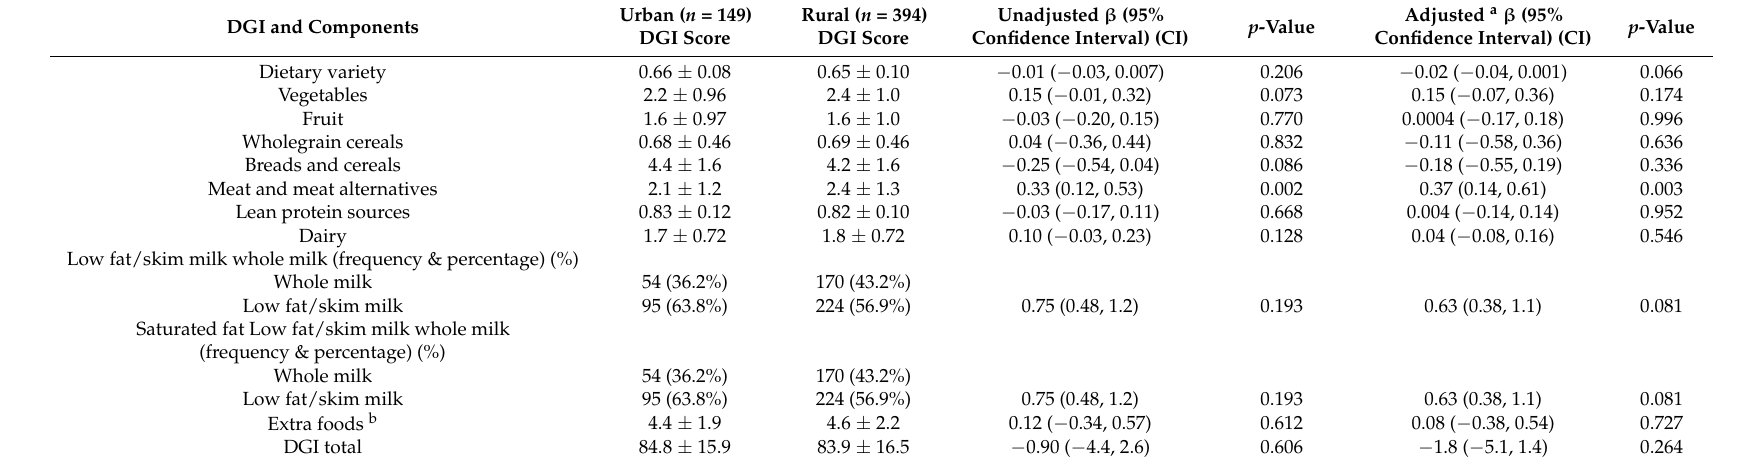
Table 4. Difference in diet quality components between urban and rural